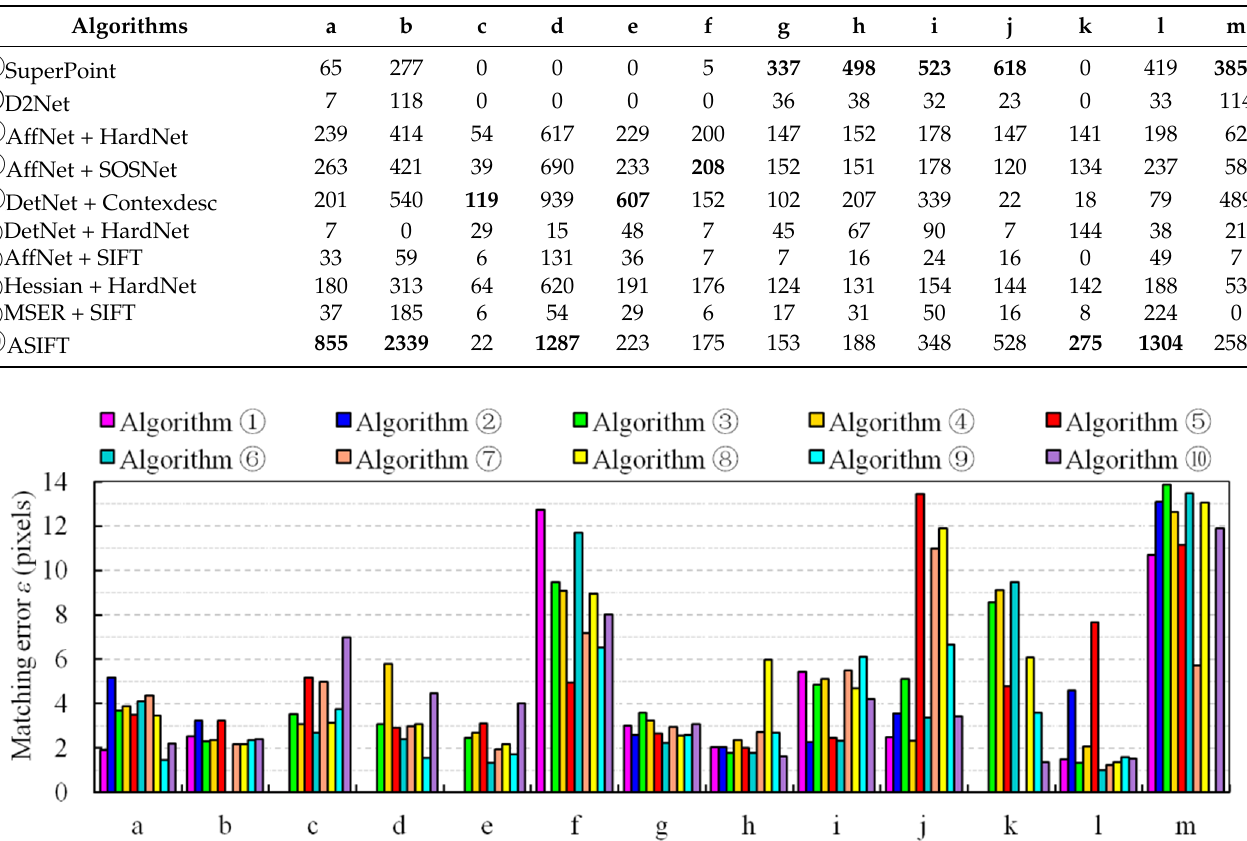
Table 3. The contrast of ten algorithms in the aspect of number of matches. Bold font denotes the best results. Table 1. Representative algorithms and their references. Algorithms